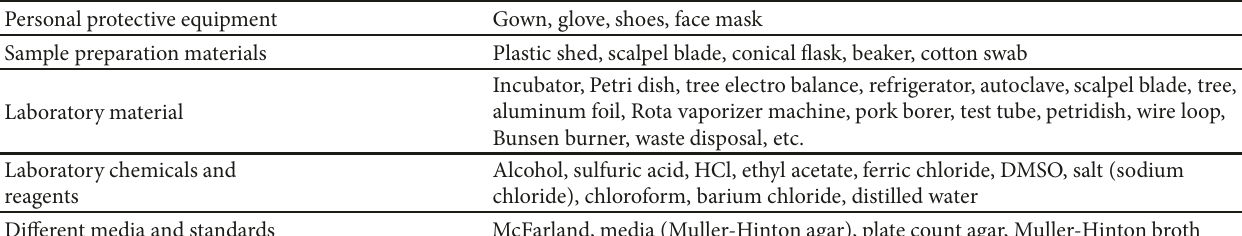
Personal protective